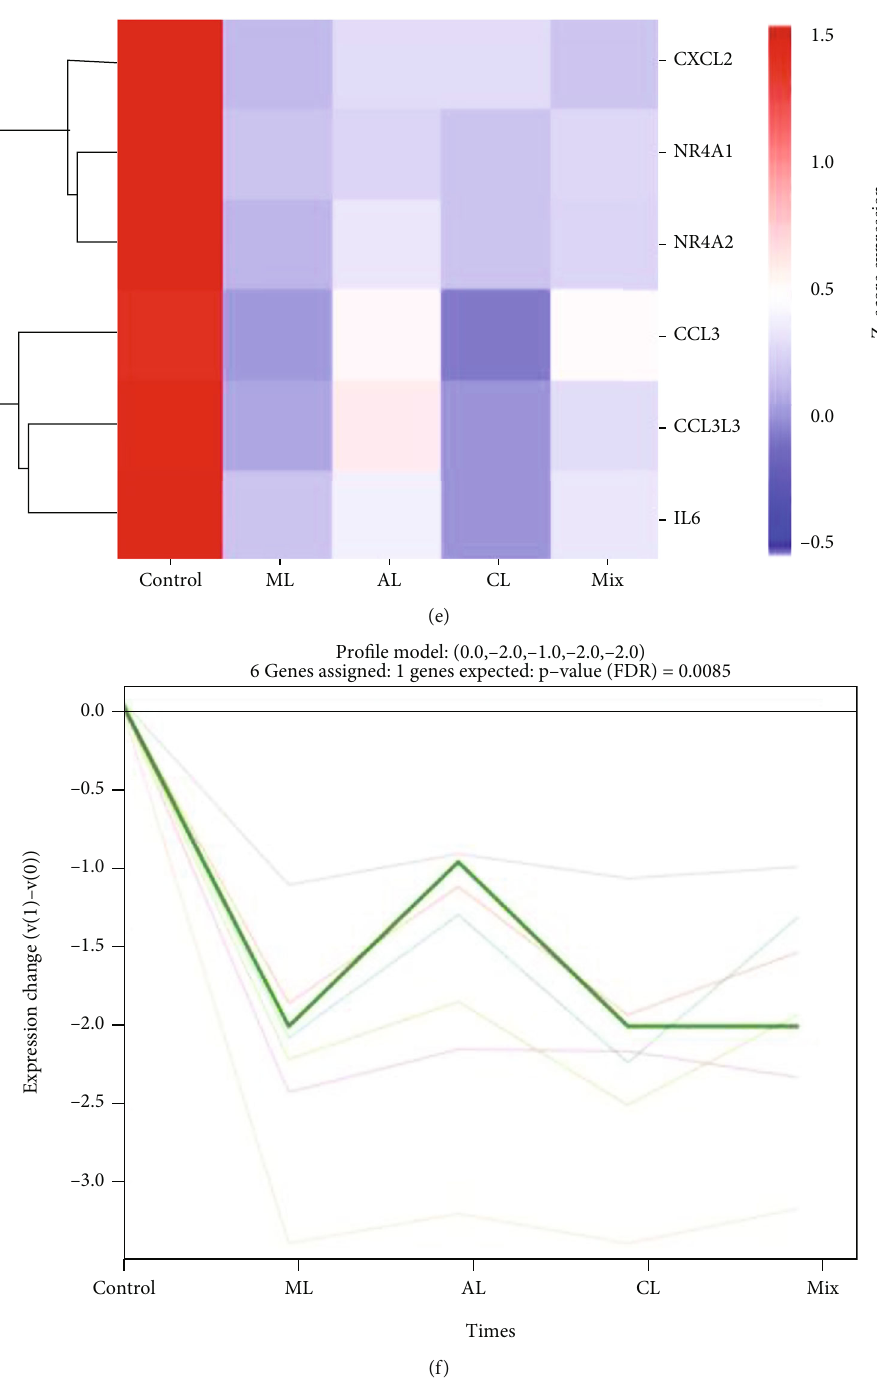
Figure 5: Short Time-Series Expression Miner (STEM) analysis. (a) Heatmap of six gene expressions in trend 1, including 6 DIRGs, ITGAL, TUBB3, ADRB2, SLP1, CCL19, and CTSG. (b) Line chart of six gene expressions in trend 1, FDR = 0 : 00017 . (c) Heatmap of seven gene expressions in trend 2, including 7 DIRGs, HLA-C, NOD1, PLAU, HLA-DRB1, HLA-DRB5, HLA-DMA, and SERPINA3. (d) Line chart of seven gene expressions in trend 2, FDR = 0 : 002 . (e) Heatmap of six gene expressions in trend 3, including 6 DIRGs, CXCL2, NR4A1, NR4A2, CCL3, CCL3L3, and IL6. (f) Line chart of six gene expressions in trend 3, FDR = 0 : 0085